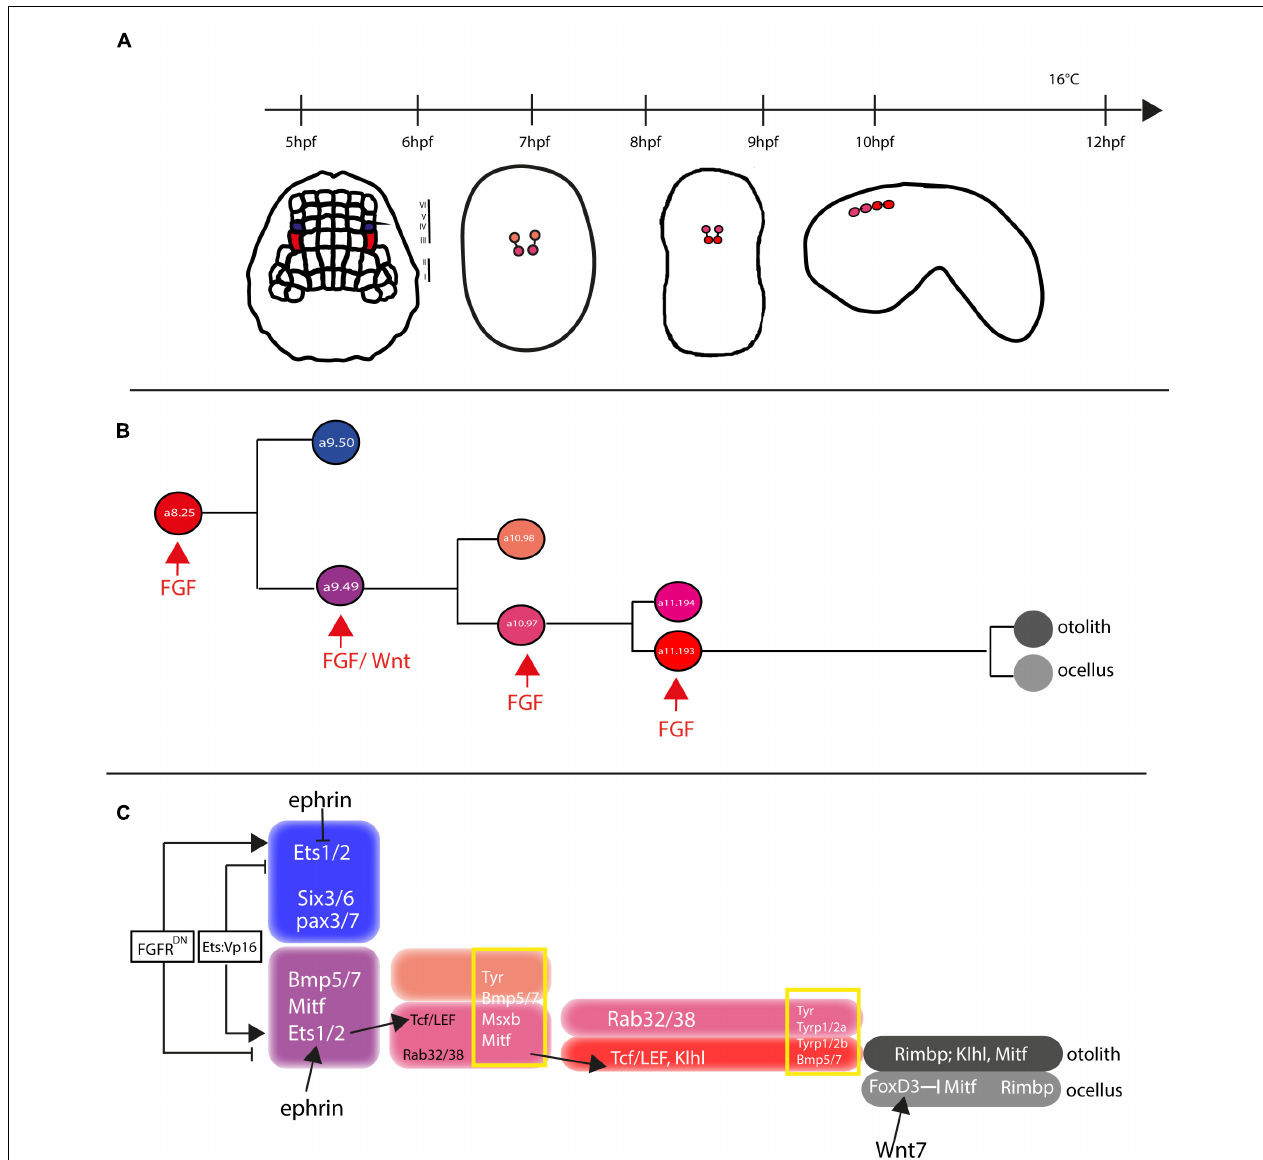
FIGURE 5 | Otolith/ocellus cell fate in Ciona robusta . (A) Summary of pigmented cell lineage development within CNS, with the developmental stages (hours post fertilization, hpf) indicated the timeline [from Racioppi et al. (2014)]. (B) Fate determination of otolith and ocellus precursors from a9.49 blastomeres, under the control of FGF [adapted from Racioppi et al. (2014)]. (C) Reconstruction of genes involved in controlling otolith/ocellus determination. Adapted from Racioppi et al.